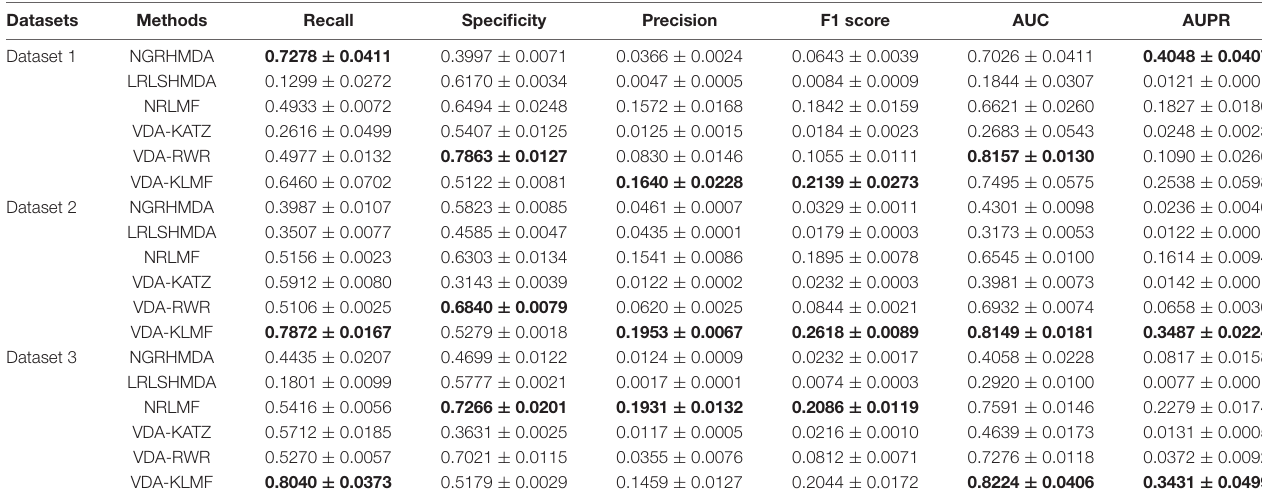
TABLE 3 | The performance of six VDA prediction methods on three datasets under CV1.